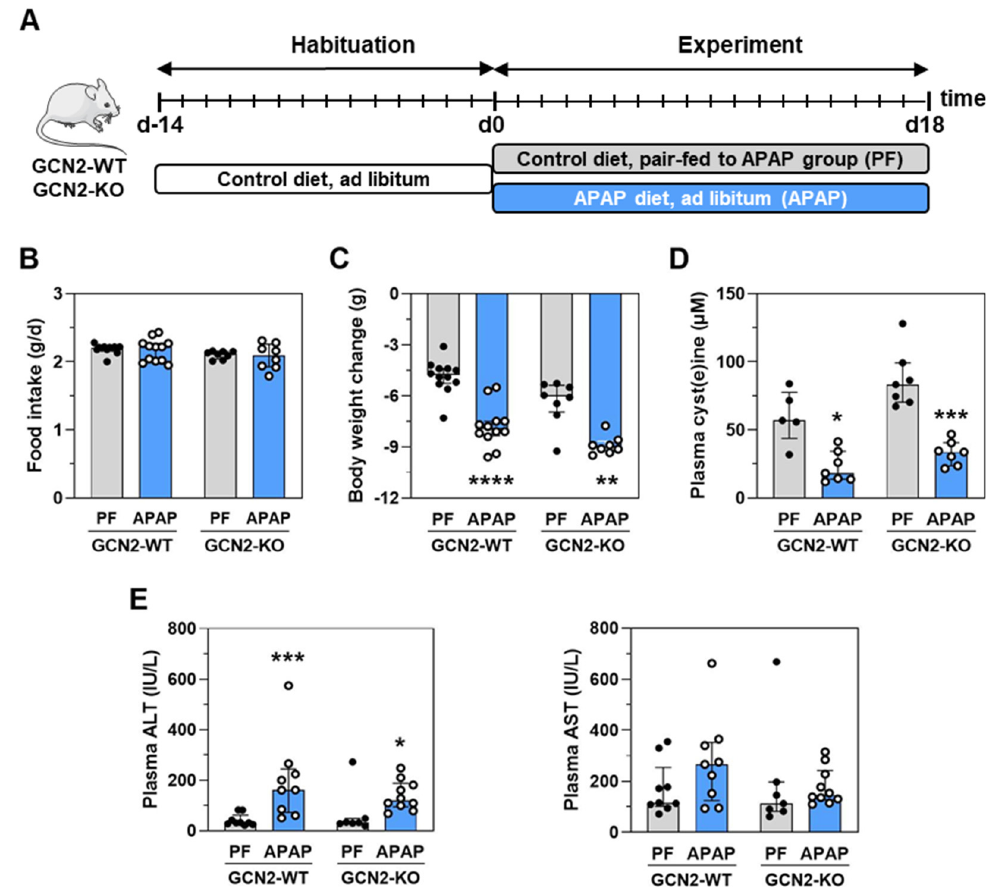
Figure 3. Effect of the absence of GCN2 in the response to treatment with APAP for 18 d. ( A ) Gcn2 null ( Gcn2 − / − ) or positive mice ( Gcn2 +/+ ) were fed the APAP diet (APAP) for 18 d or were pair-fed (PF) the Ctrl diet to match the daily food intake of the respective APAP-treated mice. ( B ) Mean daily food intake for 1–18 d. ( C ) Body weight change during the experiment. ( D ) Plasma concentration of cyst(e)ine (reduced form + homodimer + small heterodimers) at 18 d. ( E ) Plasma transaminase activities at 18 d. ALT: alanine aminotransferase AST: aspartate aminotransferase; IU: international unit. Each bar shows the median with interquartile and dots are individual values. * p ≤ 0.05; ** p ≤ 0.01; *** p ≤ 0.001; **** p ≤ 0.0001 vs. respective PF; Mann Whitney test.